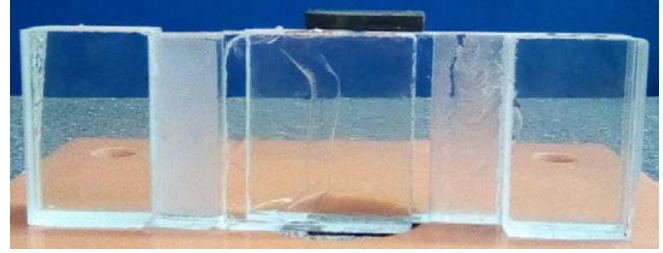
Fig. 15 SG delamination, sample dynamically loaded at 75